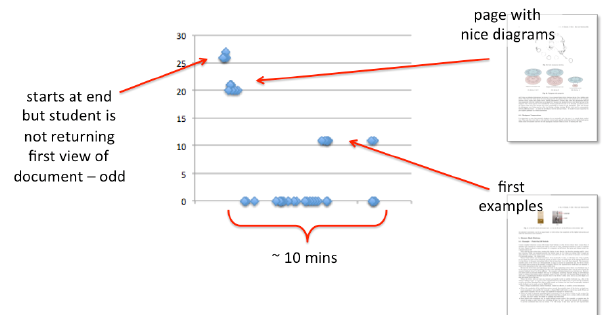
Figure 4. Individual student trace through document: skim back from end and view pages with